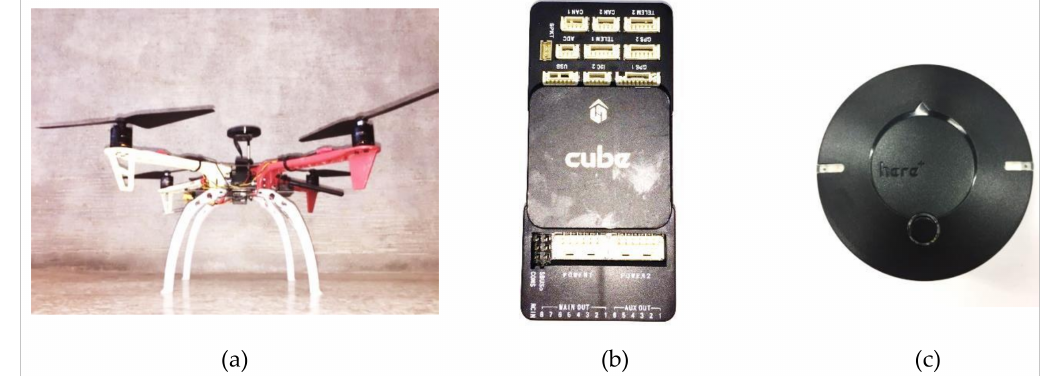
Figure 2. Main experiment devices in this study: ( a ) drone system; ( b ) Pixhawk 2 flight control module; ( c ) GPS